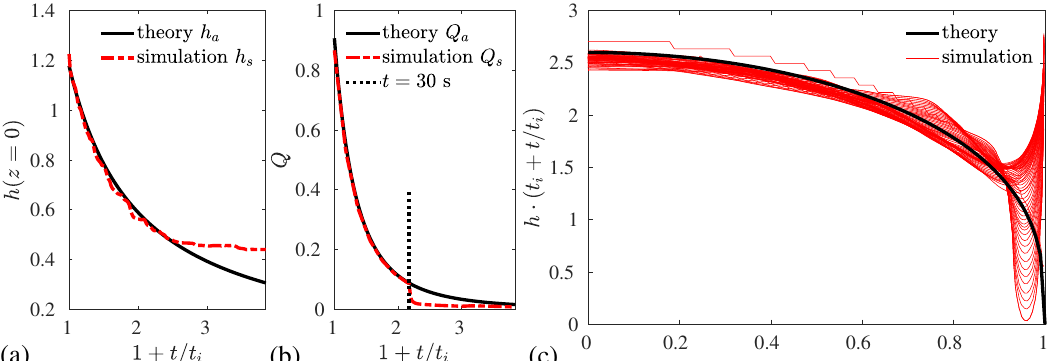
Figure 8. ( a ) h s (dashed) and h a (8) (solid) plotted against time, ( b ) Q s (dashed) and Q a (10) (solid) plotted against time, with ingestion time t = 30 s (dotted). ( c ) h · ( t i + t / t i ) (red) profiles plotted against lubrication theory (7) (black) at half second intervals for the first 30 s of draining. Simulation initial and boundary condition match lubrication prediction.